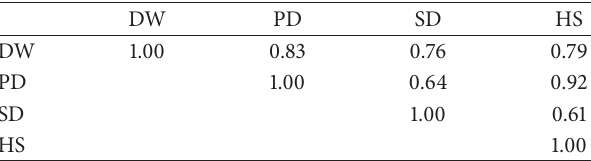
Table 4: Spearman’s Rho ( 𝜌 ) correlation values for all four variables calculatedafterthefungalfruitingbodieswerestudiedinthepresent